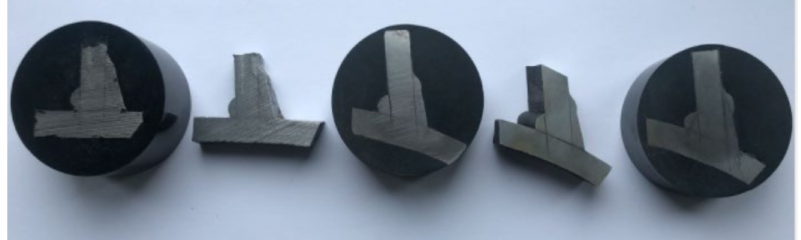
Figure 12. Actual weld profile cut from one of the